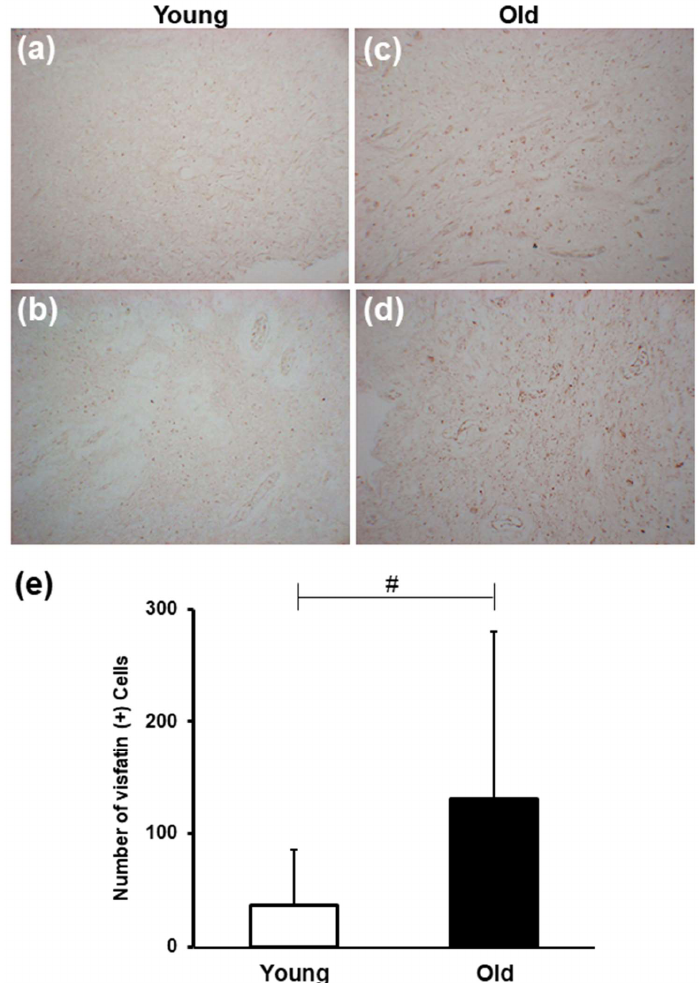
Figure 1. Age-induced changes in visfatin expression in dental pulp tissues. ( a – d ) Representative microphotographs of sections of dental pulp stained with anti-visfatin antibodies from individuals aged 17 ( a ), 20 ( b ), 35 ( c ), and 45 ( d ) years old. The number of visfatin-positive cells increased significantly in the Old group than in the Young group. All microphotographs were taken at an original magnification of × 200. Scale bar: 50 μm. ( e ) Bar graph illustrating the age-related changes in visfatin immunoexpression in the human dental pulp. Kruskal–Wallis test was performed to analyze the di ff erence in number of visfatin-positive cells between Young group and Old group. # p <